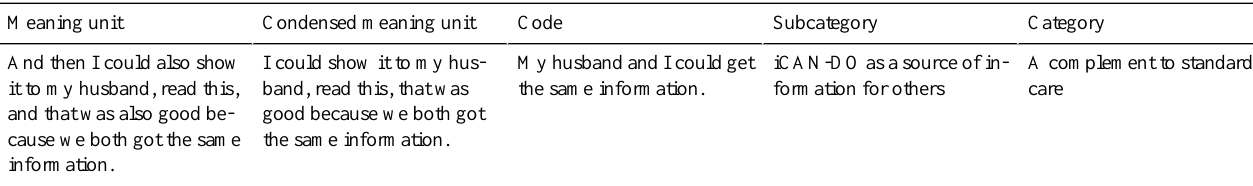
Table 3. Steps in the content analysis illustrated by a sample meaning